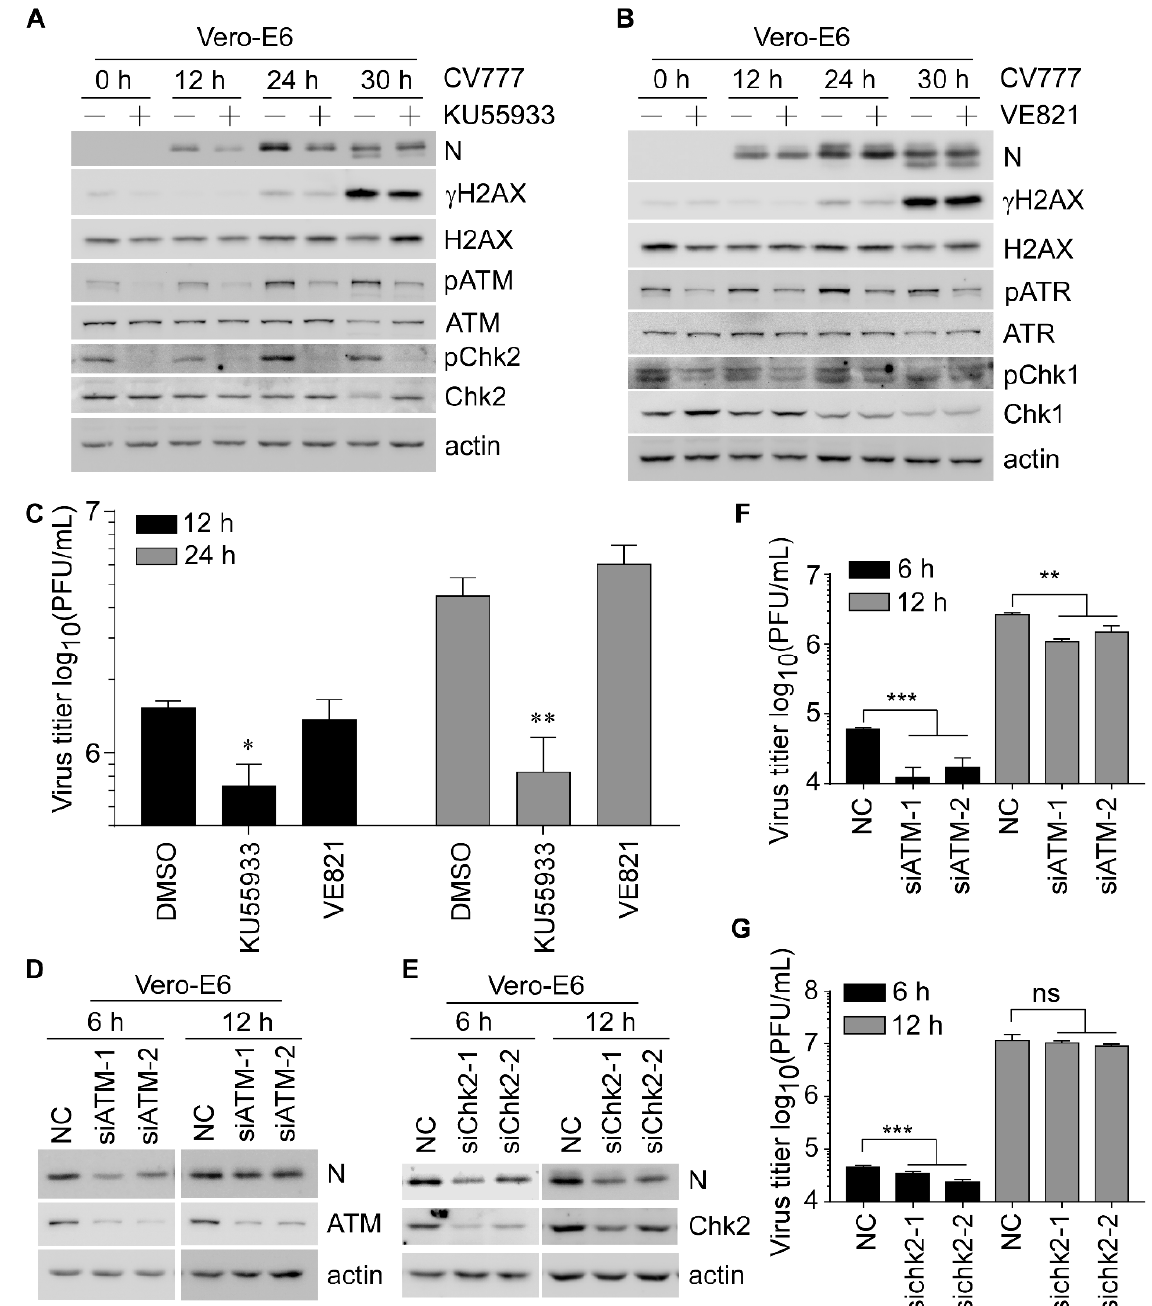
Figure 2. Suppression of the ATM signaling pathway inhibits the replication of PEDV. ( A , B ) Western blots were prepared with extracts from Vero ‐ E6 cells pretreated with DMSO, ATM antagonist KU55933 (6 μ M) ( A ), or ATR antagonist VE821 (2 μ M) ( B ) for 2 h and followed by infection with CV777 (0.5 MOI) in the presence of DMSO or KU55933 ( A ), or VE821 ( B ) for 12, 24, 30 h. ( C ) The virus titers were measured by PFU assay with supernatants harvested from Vero ‐ E6 cells pretreated with DMSO or KU55933 (6 μ M) or VE821 (2 μ M) for 2 h before and during infection with CV777 (0.1 MOI) for 12 and 24 h. ( D , E ) Western blots were prepared with extracts from Vero ‐ E6 cells transfected with scramble or 50 nM siATM ( D ), or siChk2 ( E ) for 48 h and followed by infection with 0.1 MOI CV777 for 6 and 12 h. ( F, G ) The experiment was performed as in D and E, except the cells and supernatants were collected for PFU assay (* p < 0.05; ** p < 0.01; *** p < 0.001).